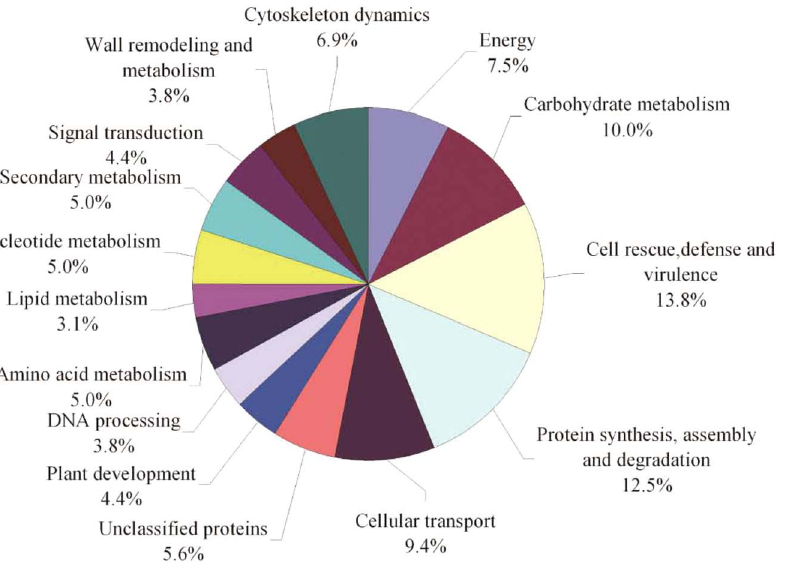
Figure 4. Functional classification of all 104 identified unique proteins. Unclassified proteins include those whose functions have not been described but may be deduced based on sequence homology analysis, as listed in Table